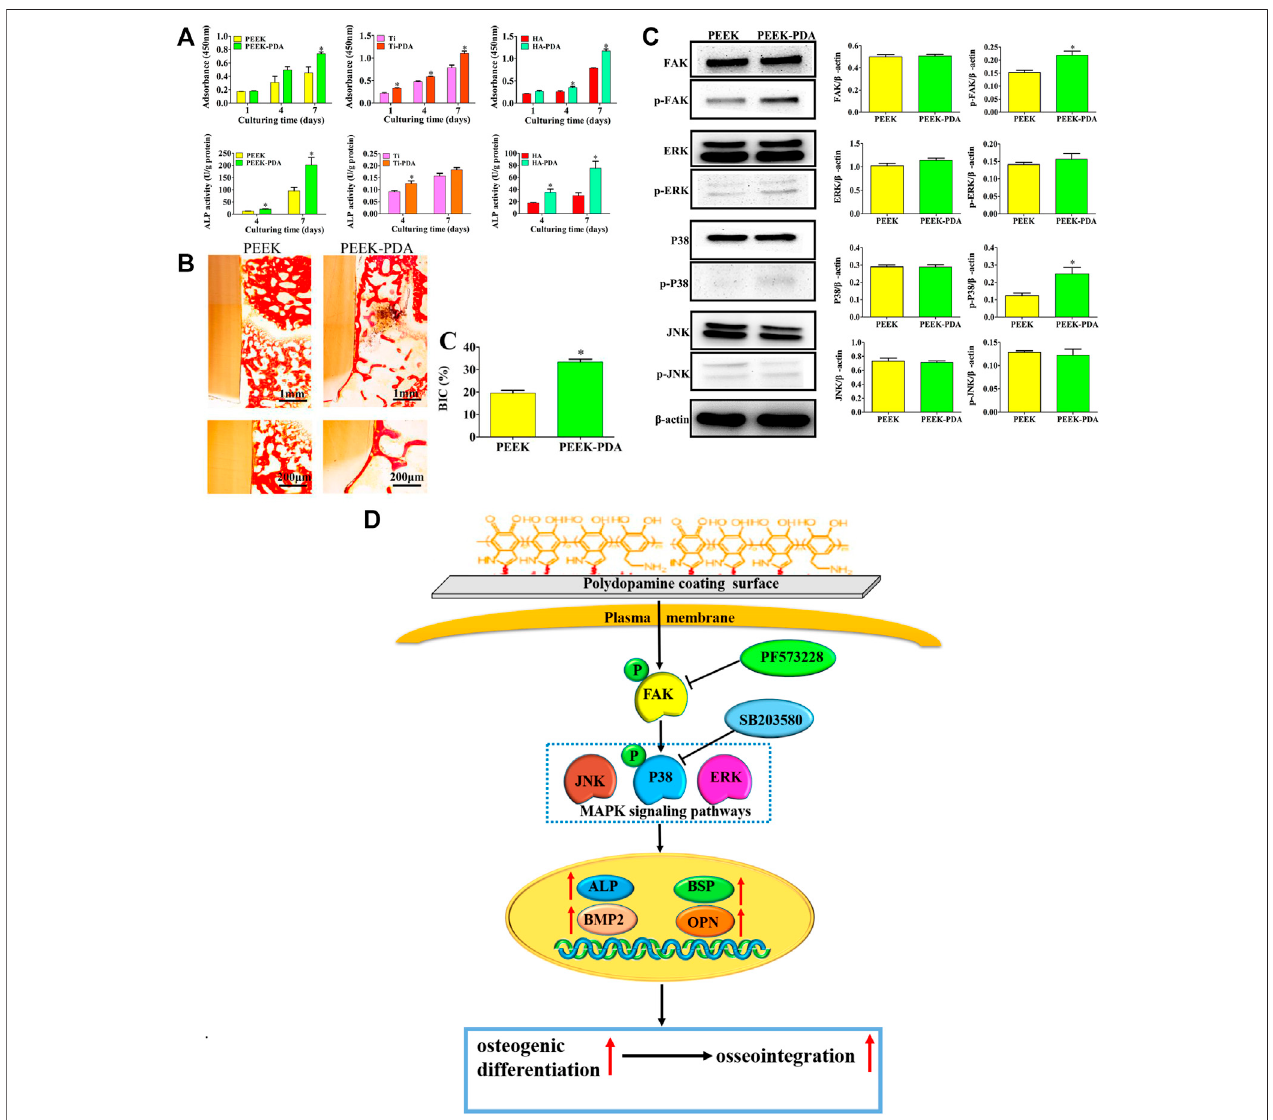
FIGURE 6 | The osteogenic activity and mechanism of PDA-coated Ti, PEEK and HA substrates. (A) The enhancement of cell proliferation and osteogenic differentiation of BMSCs on PDA-coated substrates. (B) The enhanced osseointegration of PDA-modi fi ed PEEK implants via histomorphometry analysis. (C) Western blot experiments and quantitative analysis of the expression of FAK, p-FAK, and MAPK signaling pathways proteins of BMSCs after culturing for 48 h. (D) Schematic diagram for the mechanism of enhanced osteogenic differentiation and osseointegration of PDA coating. (* p < 0.05) (Wang H. et al., 2019). Copyright 2019, American Chemical